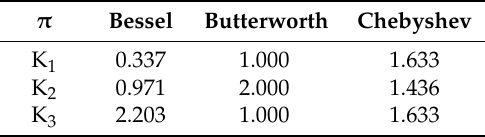
Table 1. Normalized values of π type 3 order LC filter.